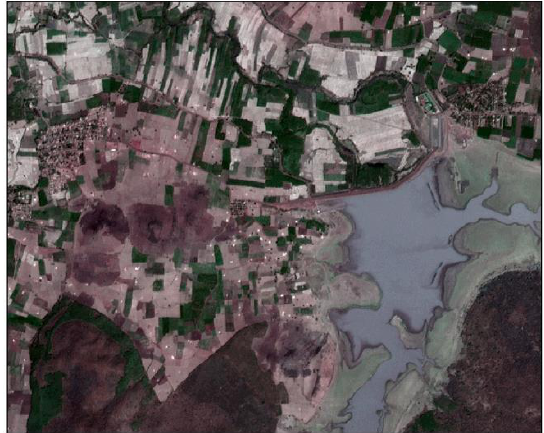
Figure 6: LISS-IV (Test Site 1) Simulated Natural Color Composite This result was also compared NCC simulated using Linear Transformation and ERDAS NCC algorithm.